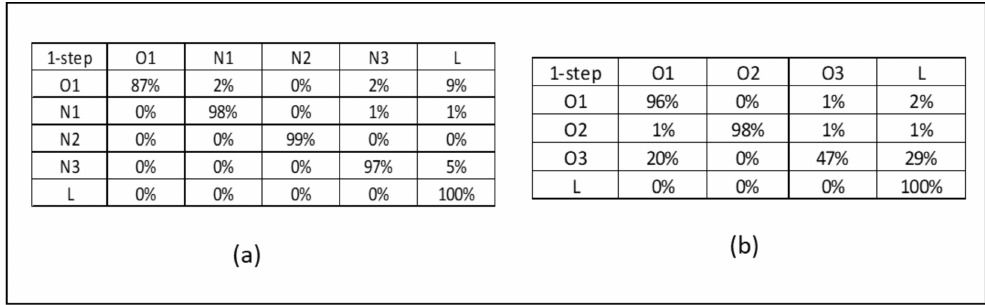
Figure 4. One-step transition matrix for Patient Group 1 ( a ) and Patient Group 2 ( b ).